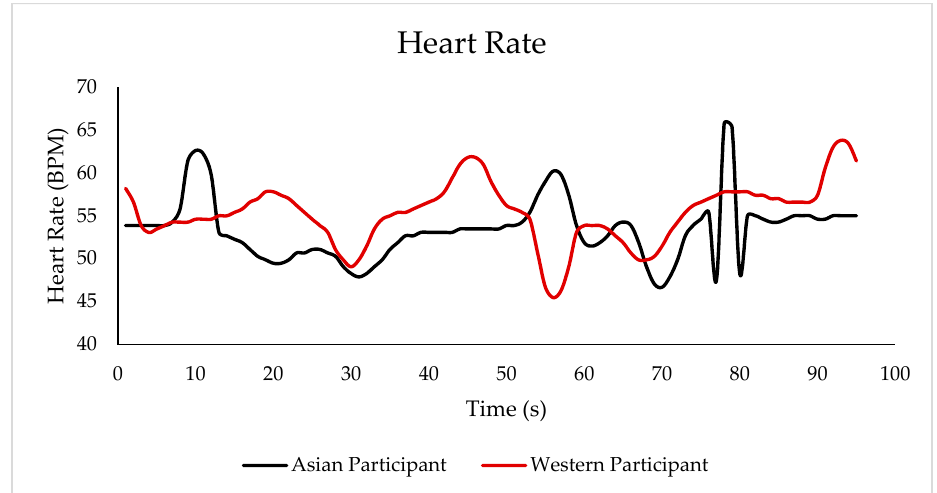
Figure 6. Example of the heart-rate changes over time when tasting a porter beer using the responses of an Asian and a Western participant.